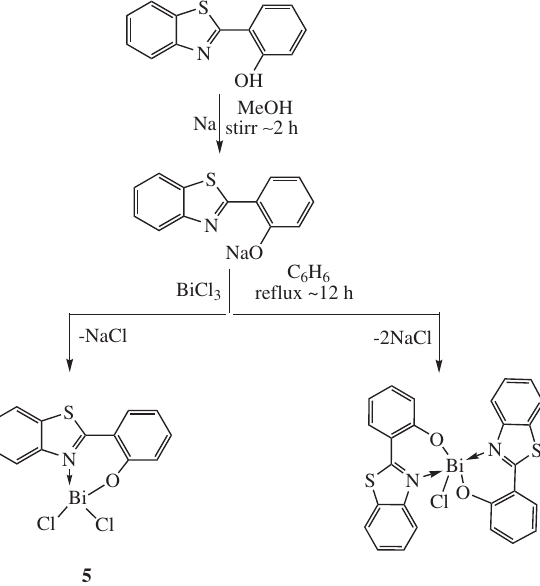
Scheme 2: General method for the preparation of bismuth(III) complexes.